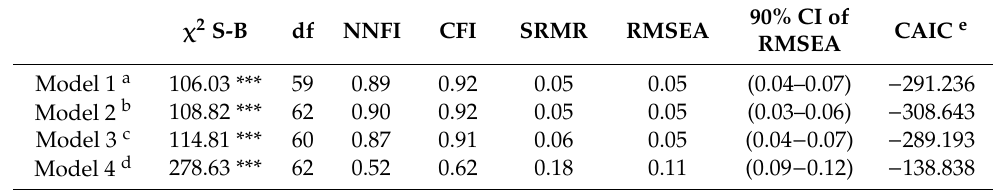
Table 4. Goodness of fit indices for the non-nested models.